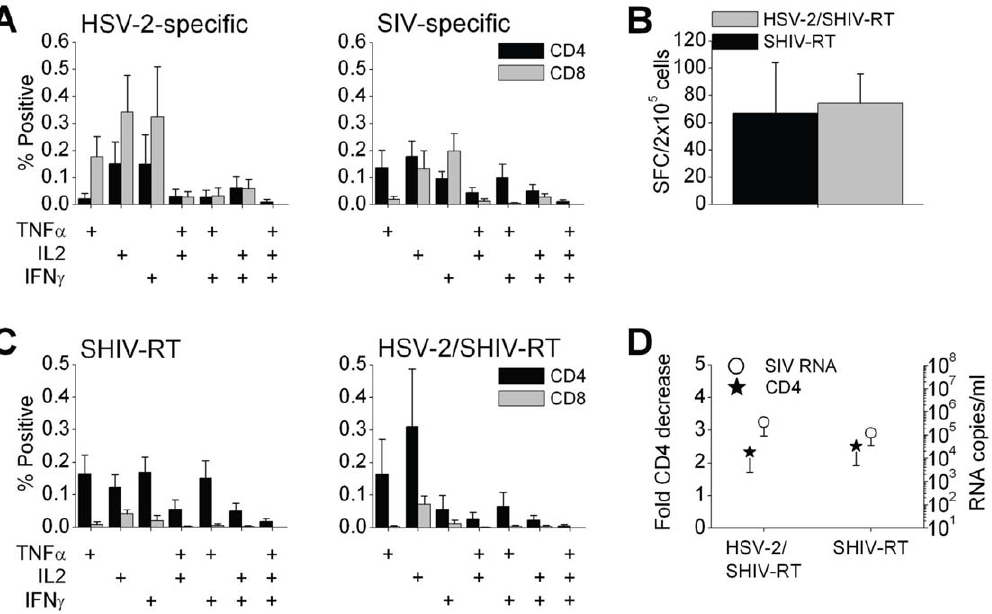
Figure 5. HSV-2-specific CD4 + and CD8 + T cell responses are detected in HSV-2/SHIV-RT co-infected animals. (A) HSV-2- (left panel) and SIV-specific (right panel) CD4 + (black bars) and CD8 + (grey bars) T cells were detected in the blood of co-infected animals ( , 12 months after co- challenge, n=8) by multicolor ICS. The percent positive cells producing the indicated cytokines in response to each antigen (mean 6 SEM; single vs double or triple producers) are shown after subtracting the respective background signals of the IgG and no-virus MV controls. (B,C) SIV-specific T-cell responses were compared between SHIV-RT-infected (n=5) and HSV-2/SHIV-RT co-infected (n=5) animals , 12 months post co-challenge, by IFN c ELISPOT (B) or ICS (C). (B) The mean ( 6 SEM) SIV-specific SFC/2 6 10 5 cells are shown. (C) The percent positive cells producing the indicated cytokines in response to SIV (mean 6 SEM; single vs double or triple producers) are shown after subtracting the respective background signals of the IgG and no- virus MV control. (D) Approximately 12 months after challenge with SHIV-RT or co-challenge with HSV-2/SHIV-RT, the fold decreases in CD4 counts (mean 6 SEM, relative to pre-exposure levels) (left axis, stars) and plasma viral loads (mean RNA copies/ml 6 SEM, right axis, circles) are shown (n=5 for